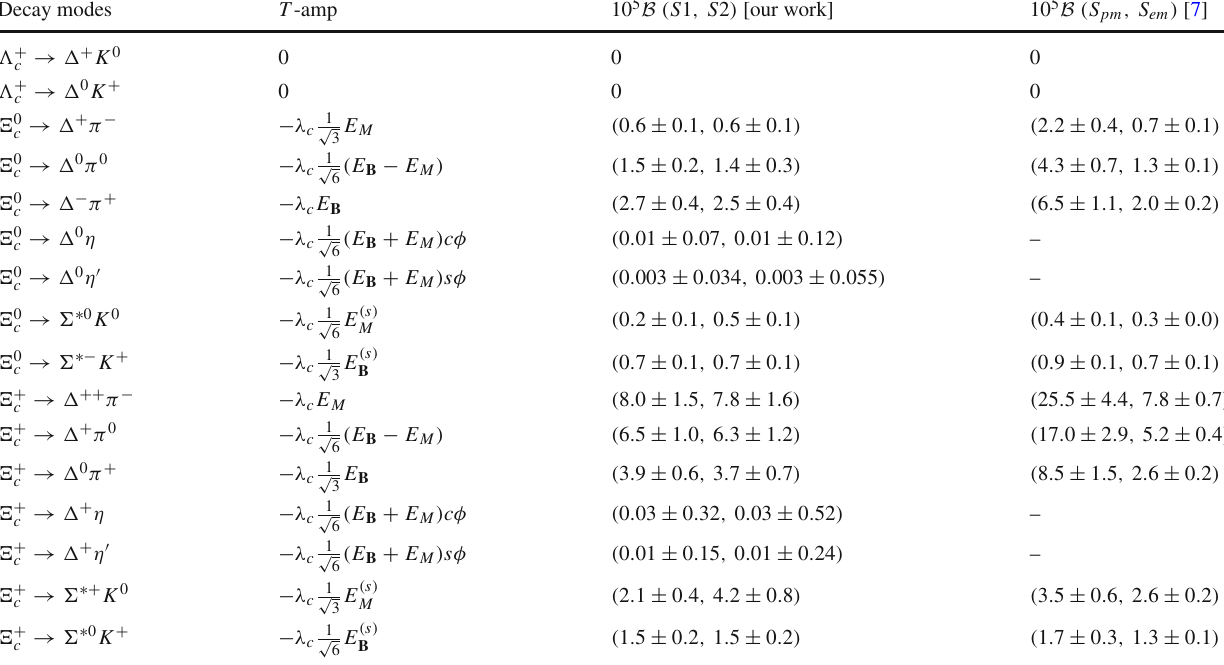
Table 3 Doubly Cabibbo-suppressed B c → B ∗ M decays Decay